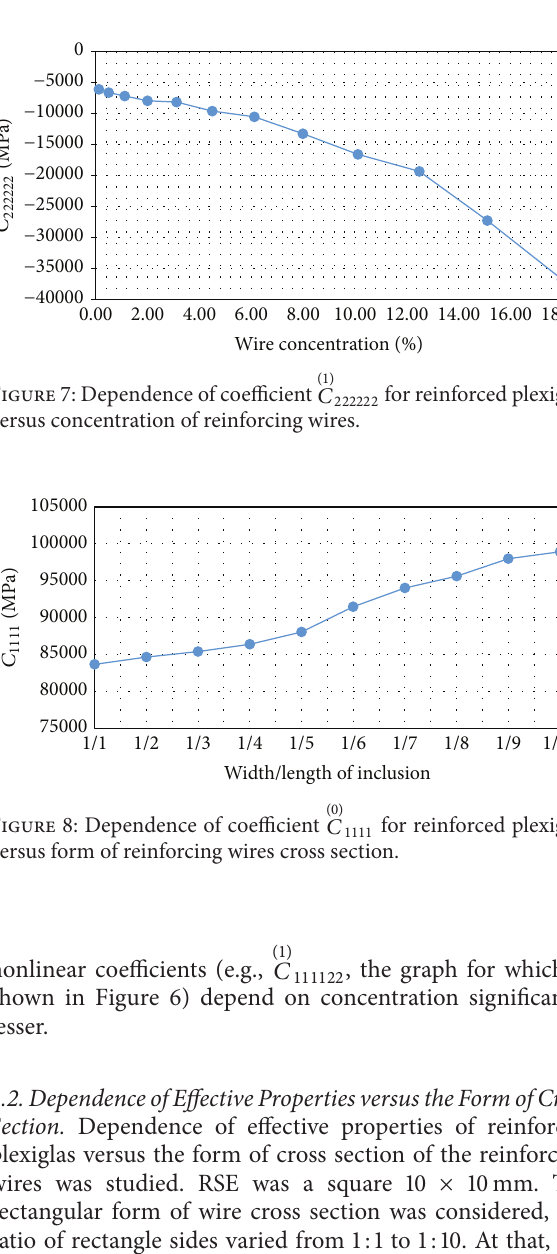
Figure 11: Dependence of coefficient versus form of reinforcing wires cross section.